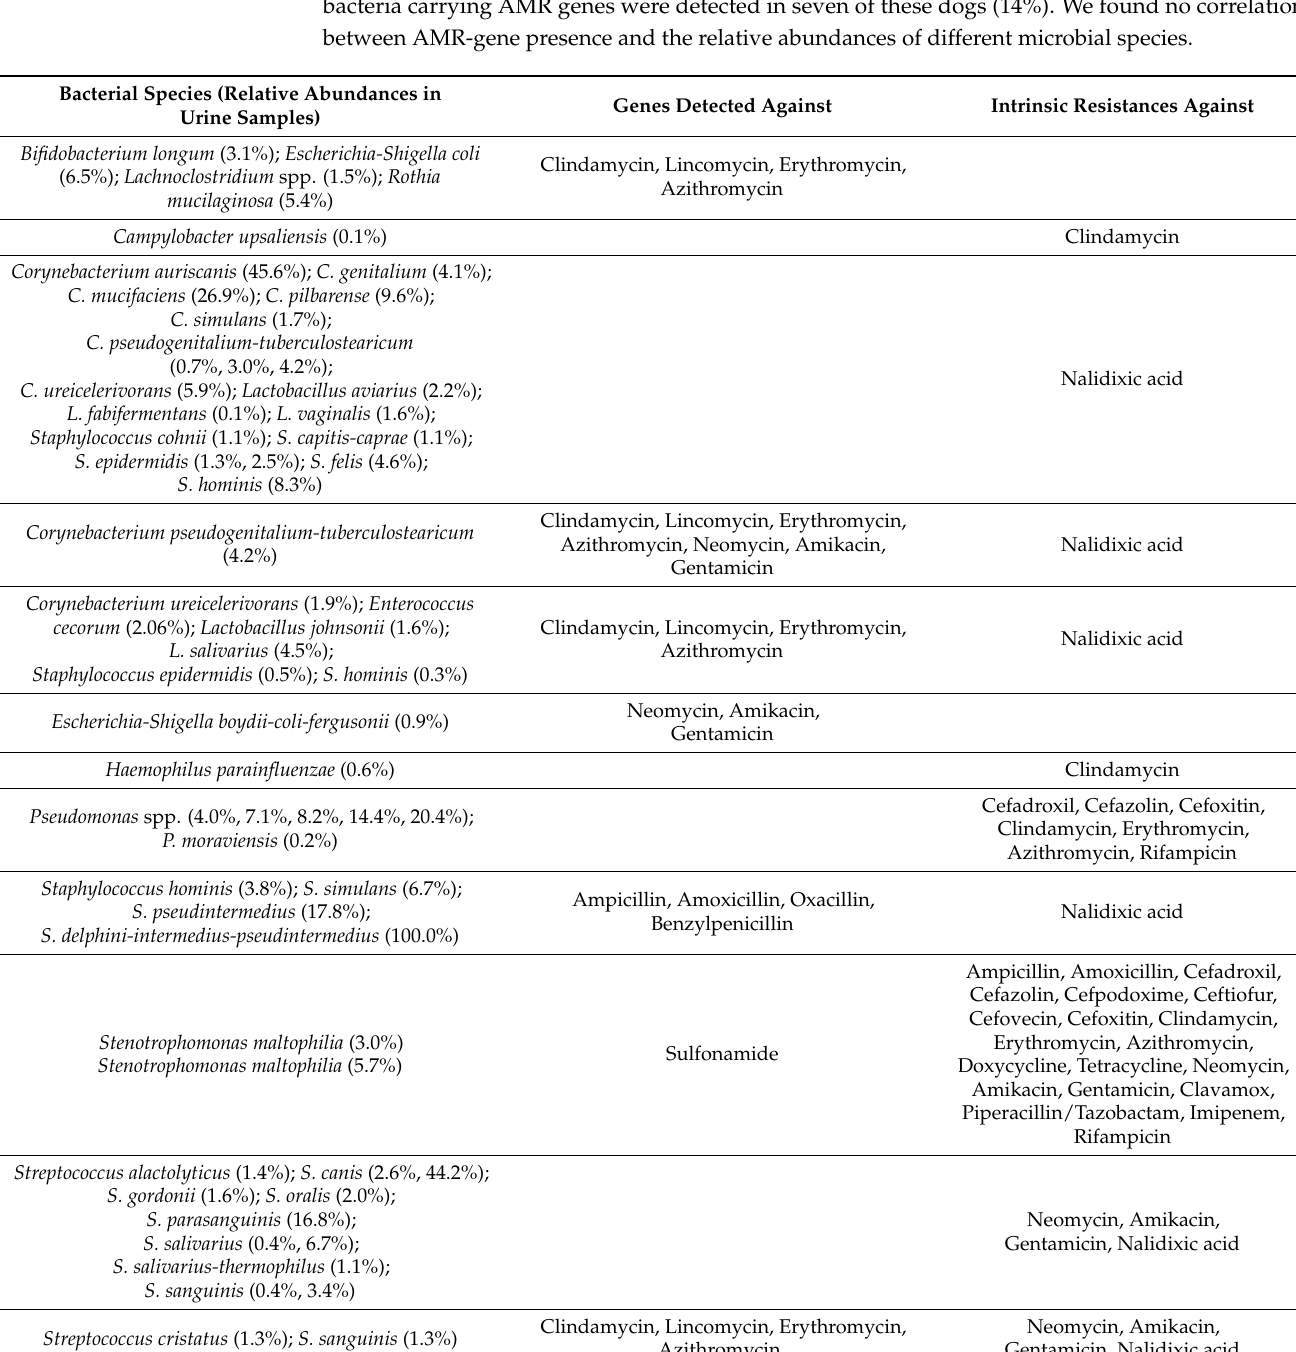
Table 2. Antimicrobial-resistance genes detected in canine urine samples. Bacteria with intrinsic resistances (inferred) to antimicrobials were present in samples from twelve of the dogs (24%), while bacteria carrying AMR genes were detected in seven of these dogs (14%). We found no correlation between AMR-gene presence and the relative abundances of different microbial